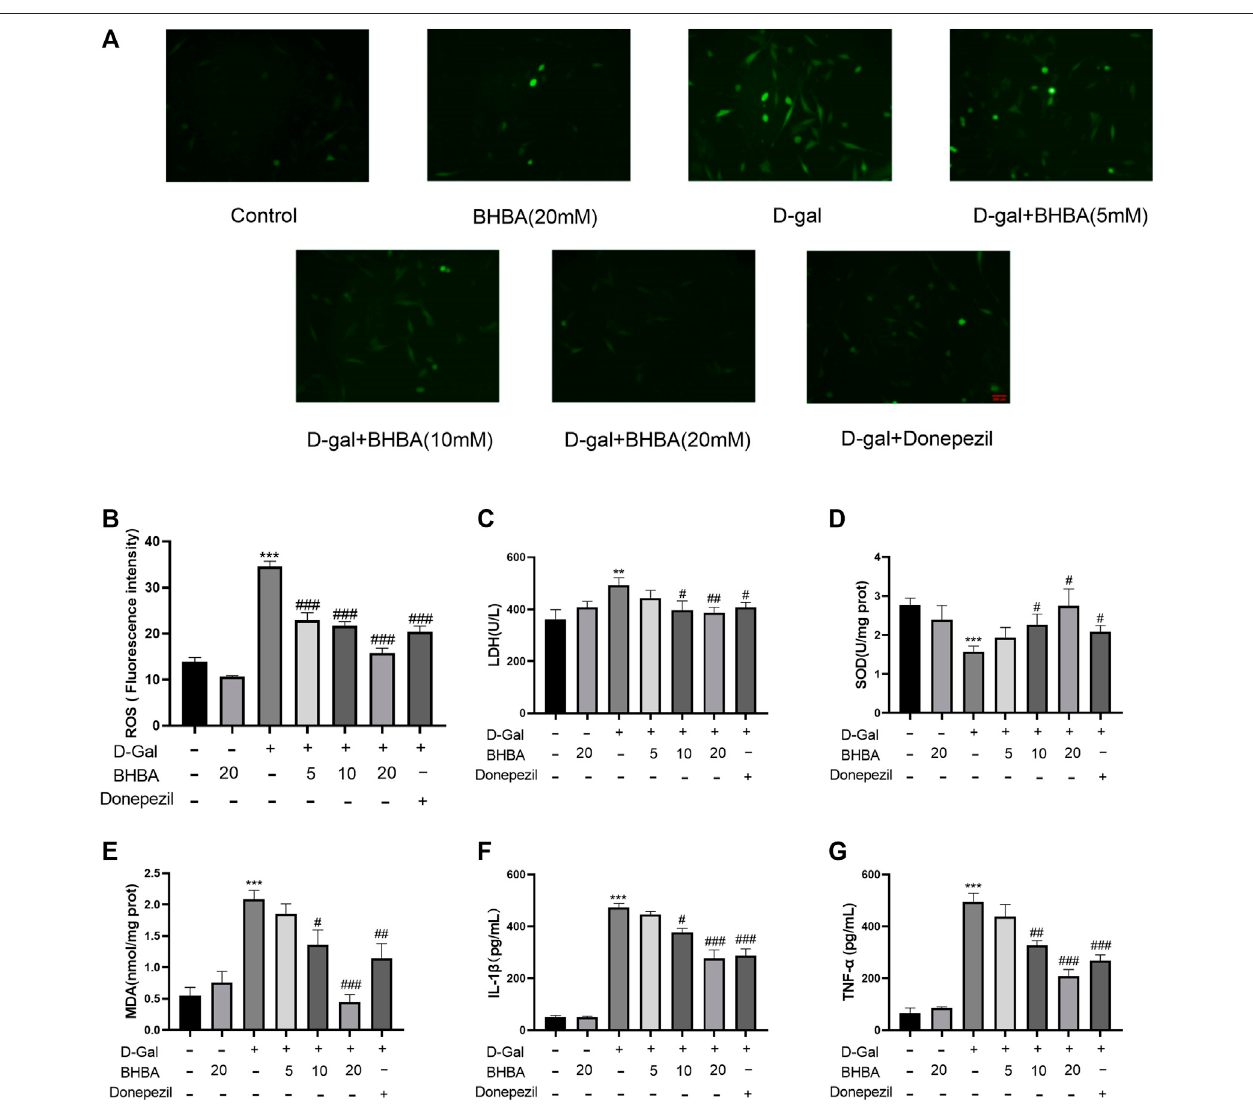
FIGURE 5 | Effects of BHBA on oxidative stress and in fl ammation in D-gal-induced HT22 cells. (A) Fluorescence of ROS (magni fi cation: 200X). (B) Fluorescence intensity of ROS. (C) Activity of LDH. (D) Activity of SOD. (E) Content of MDA. (F) Content of IL-1 β . (G) Content of TNF- α . D-gal: 200 mM; BHBA: 5, 10, and 20 mM, respectively;donepezil:2 μ M,n (cid:1) 3 – 6.Comparedwiththecontrolgroup,** p < 0.01,*** p < 0.001;comparedwiththeD-galgroup,# p < 0.05,## p < 0.01,### p < 0.001.